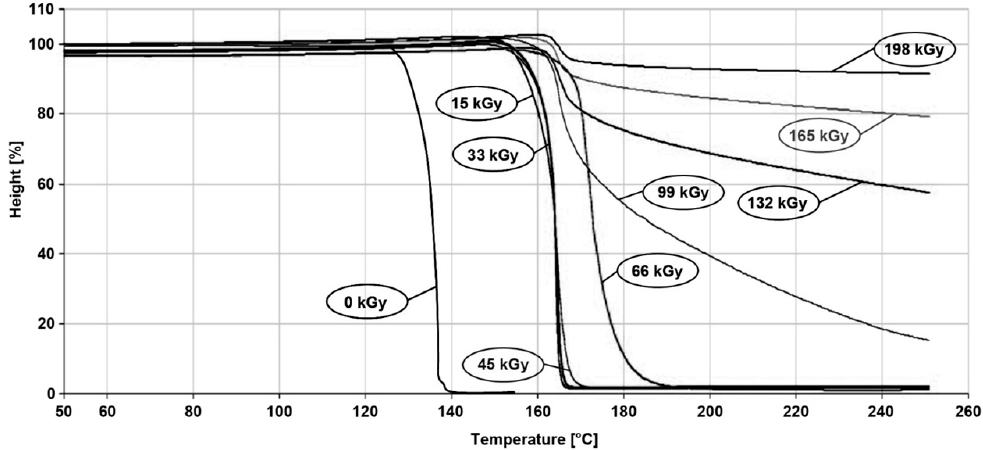
Figure 9. TMA—Commodity polymers (HDPE).